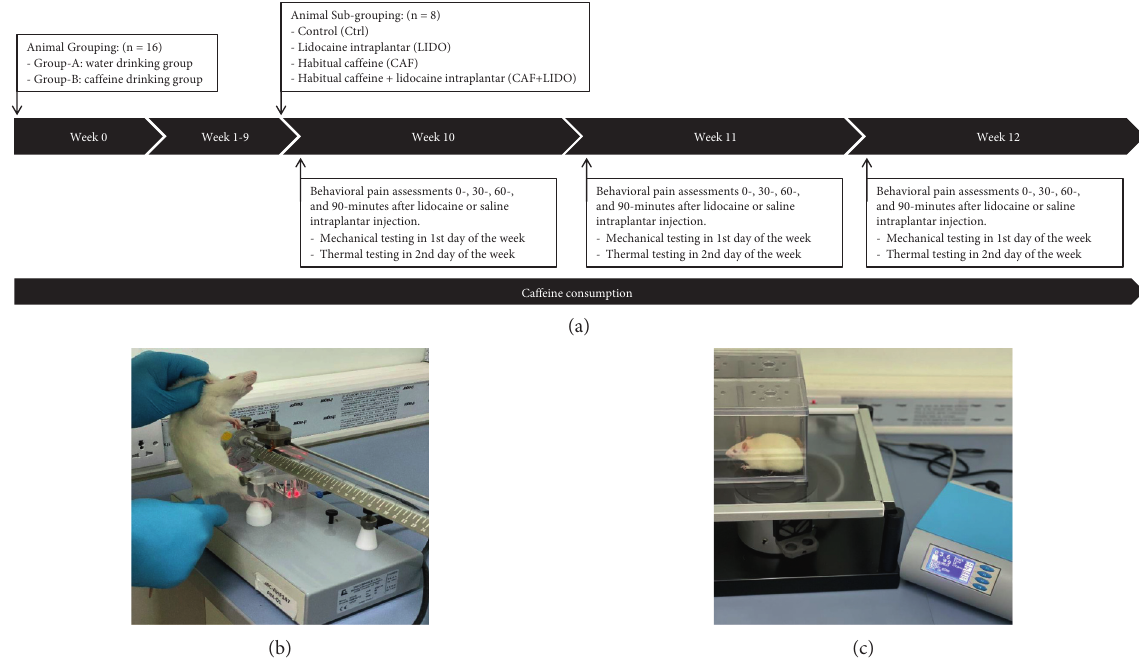
Figure 1: Experimental design and pain sensation testing. (a) Experimental design: at week 0, animals were allocated into group A, the water drinking group, and group B, the caffeine drinking group ( n � 16). At the end of the 9th week, animals were subdivided into 4 subgroups ( n � 8): control (Ctrl), receiving an intraplantar lidocaine injection (LIDO), habitual caffeine intake (CAF), and habitual caffeine intake and receiving an intraplantar lidocaine injection (CAF+ LIDO). Mechanical testing was conducted on the 1st day of weeks 10, 11, and 12, while thermal testing was conducted on the 2nd day of weeks 10, 11, and 12. Both mechanical testing and thermal testing were performed 4 times per day (0, 30, 60, and 90 minutes) after intraplantar lidocaine or saline injections. (b) Mechanical pressure sensation testing (Randall–Selitto test): the tip of the Analgesy Meter was applied with increasing force on the dorsal surface of the rat’s hind paw until a withdrawal response was obtained. (c) Thermal pain sensation testing (paw withdrawal latency test): an infrared light, a thermal heat stimulus, was placed underneath the injected paw until the withdrawal reflex was